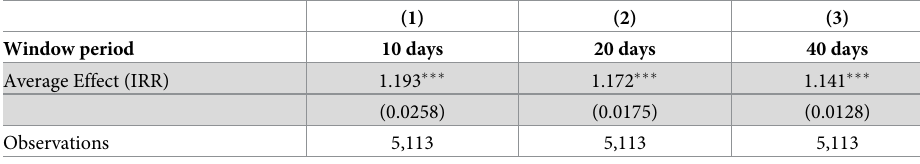
Table 4. Average effect on days after celebrity death